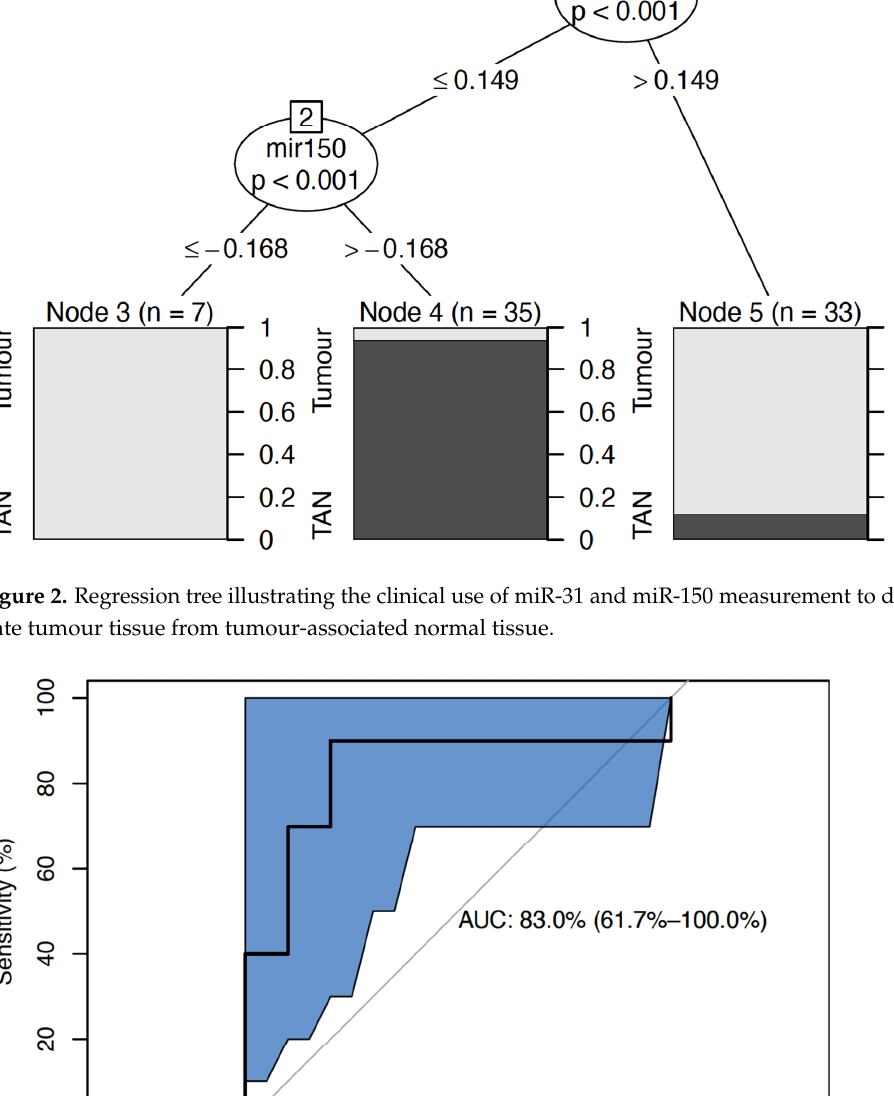
Table 5. Comparison of the mean and median expression levels of miRNA targets in the circulation of 34 independent colorectal cancer patients and 5 ‘normal’ controls.